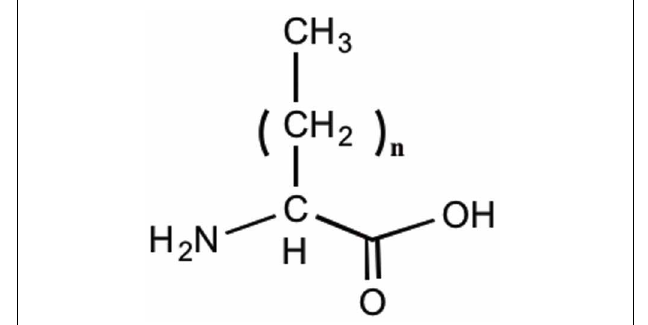
FIGURE 3 | Structure of lipoamino acids.